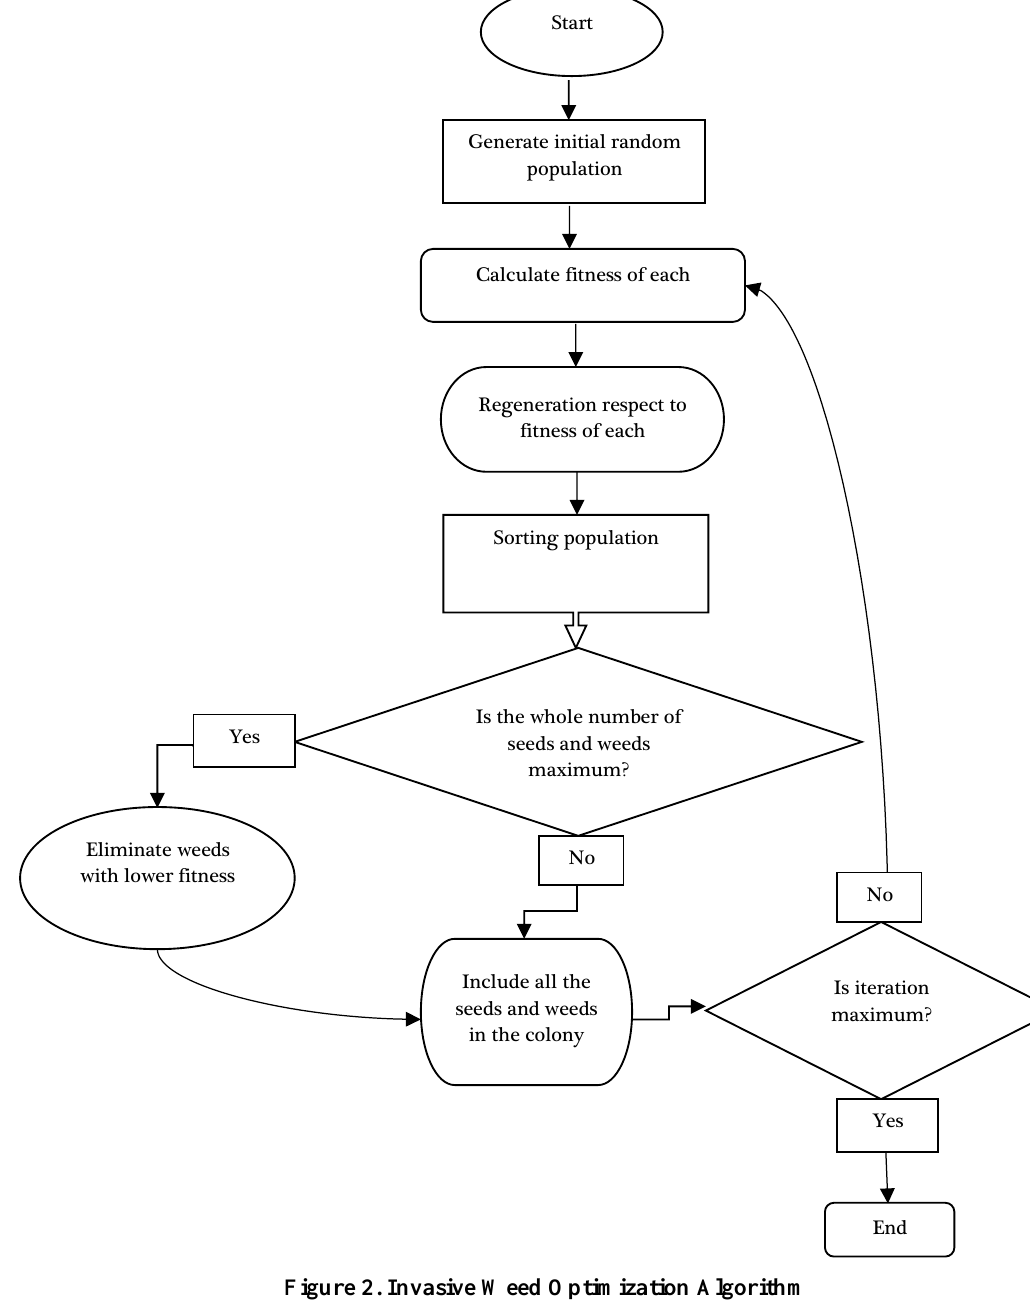
Figure 2. Invasive Weed Optimization